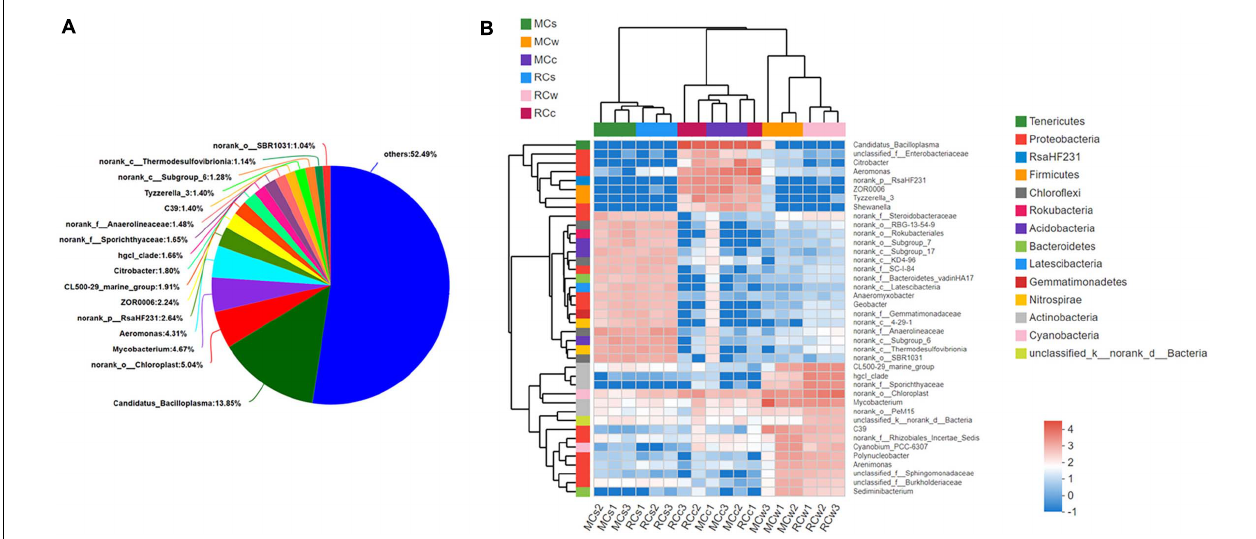
FIGURE 3 | Genus-level composition of the bacterial community in the samples. (A) Overall bacterial community composition at the genus level (all samples pooled together). Low abundance sequences (i.e., < 1% abundance) were combined and specified as “others.” (B) Distribution of the 40 most abundant genera across all samples. The log-transformed relative abundance of each genus in sample is depicted by color intensity. Bray–Curtis distances are shown at the top. TABLE 1 | ANOSIM/Adonis